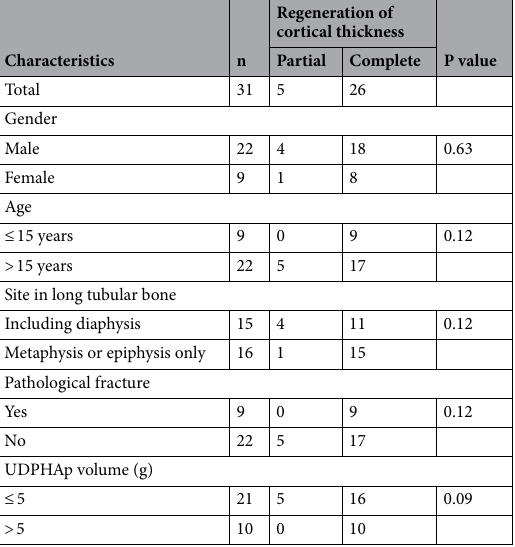
Table 3. Clinical factors influencing regeneration of preoperative cortical